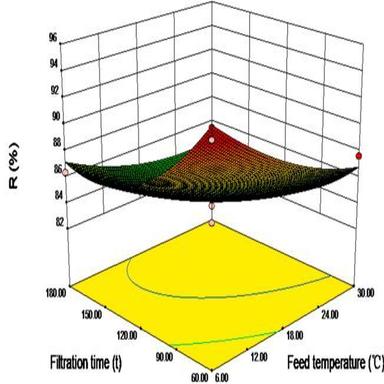
Response surface plot of the rejection of total soluble salts vs. the feed temperature and filtration time.